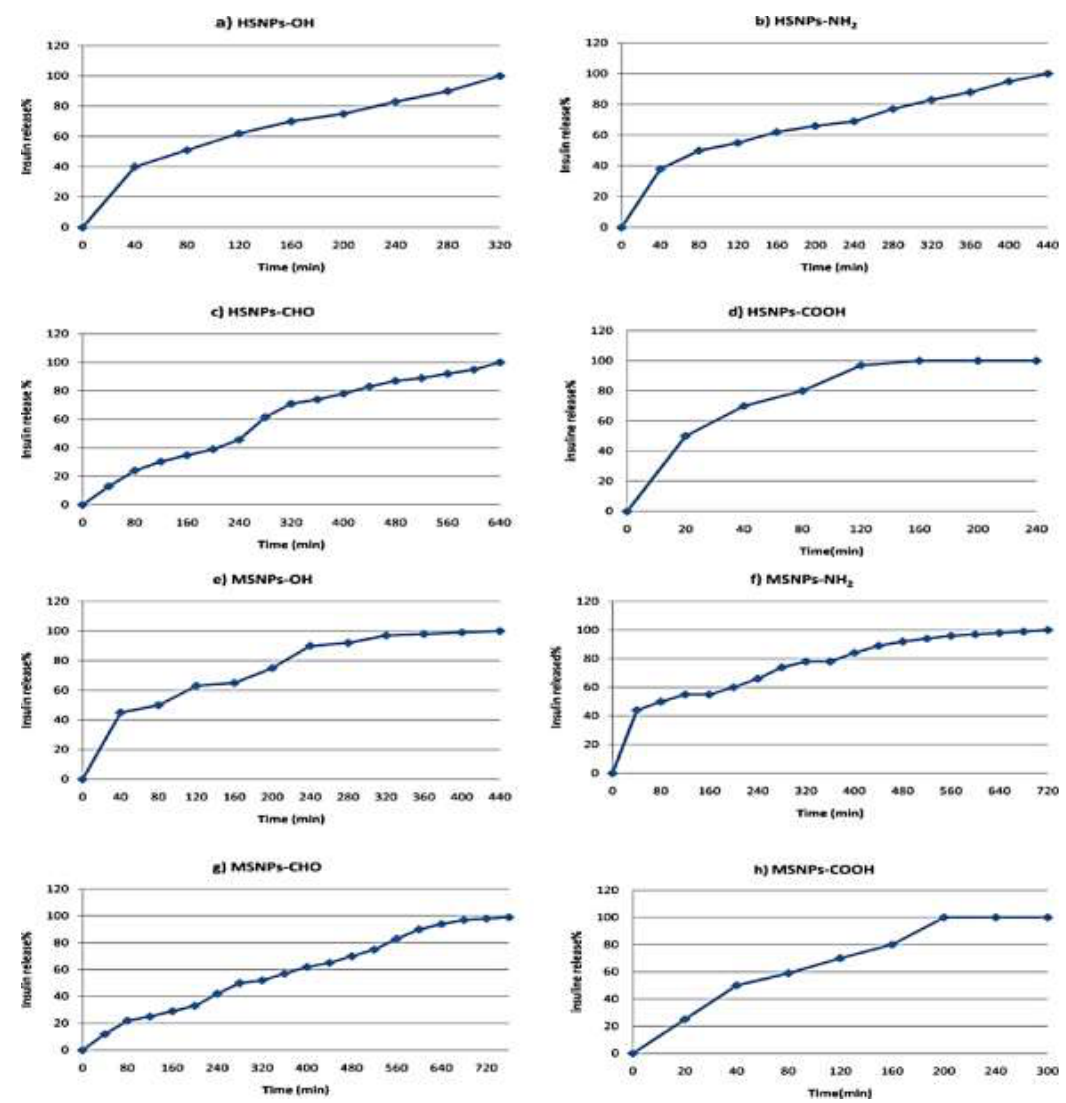
Fig. 6. Release of insulin from different carriers as a function of time at 37±1 °C. (a) HSNPs-OH, (b) HSNPs-NH (d) HSNPs-COOH, (e) MSNPs-OH, (f) MSNPs-NH